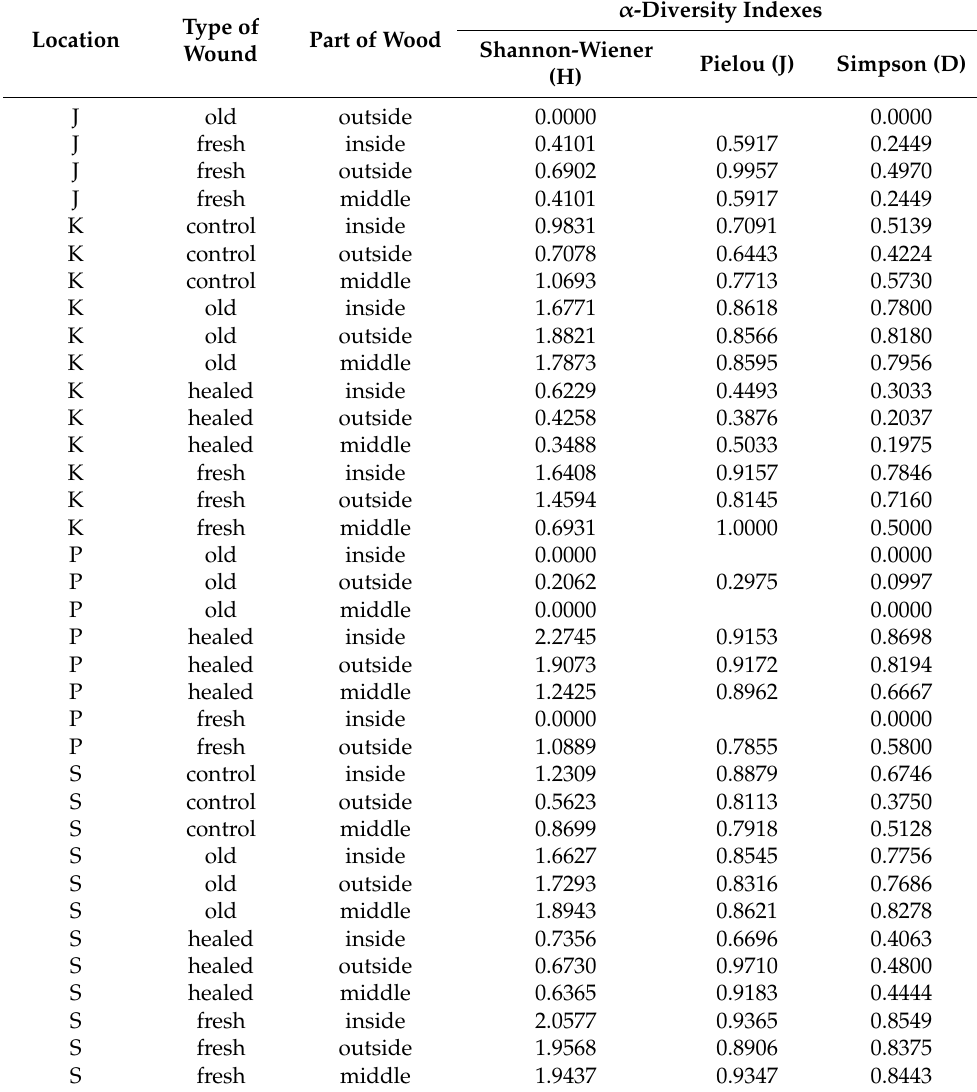
Table 5. α -diversity indexes values calculated per every type of sample. Abbreviations: J—Suhora